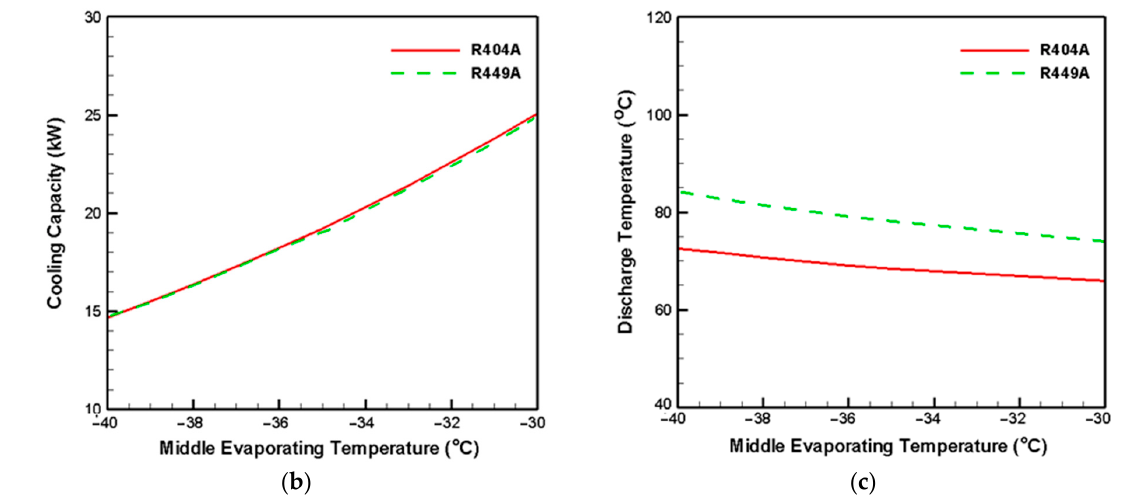
Figure 8. ANN modelling results for ( a ) COP, ( b ) cooling capacity, and ( c ) discharge temperature of the supermarket refrigeration system at LT application.